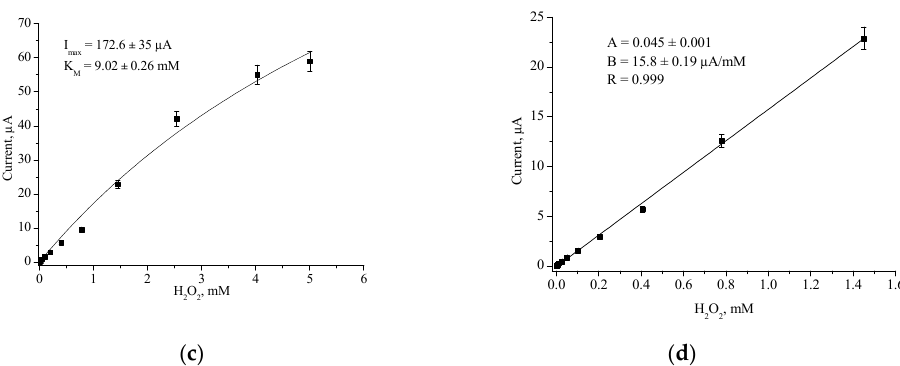
Figure A1. Amperometric characteristics of nCuCe/GE as a chemosensor of H 2 O 2 . ( a ) CV profiles as current responses upon addition of analyte up to concentrations (mM): 0 (1, black); 2.5 (2, red); 5.0 (3, blue); 10 (4, green). ( b , c ) chronoamperometric response and dependence of amperometric signal on concentration of H 2 O 2 , respectively; ( d ) calibration graph for H 2 O 2 determination. Conditions: Ag/AgCl (reference electrode) in 50 mM PB, pH 7.0; scan rate 50 mV·s − 1 ( a ); working potential —50 mV ( b – d ).